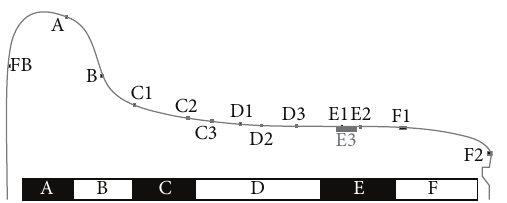
Figure 10: Locations of microstructural shear images on the wheel tread cross section. Note that the machined groove on the rim face indicates the minimum wheel diameter.